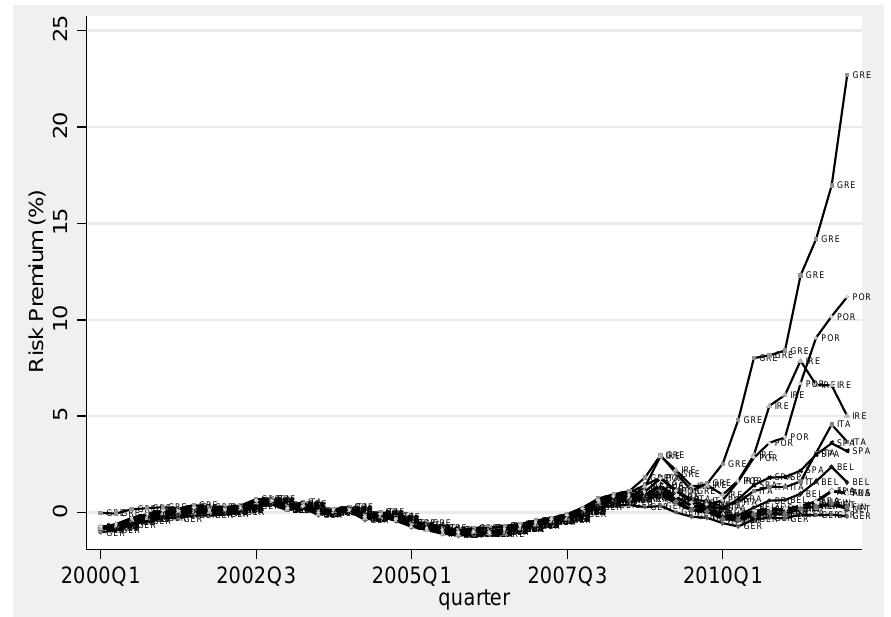
Figure 2. Risk premia in EMU